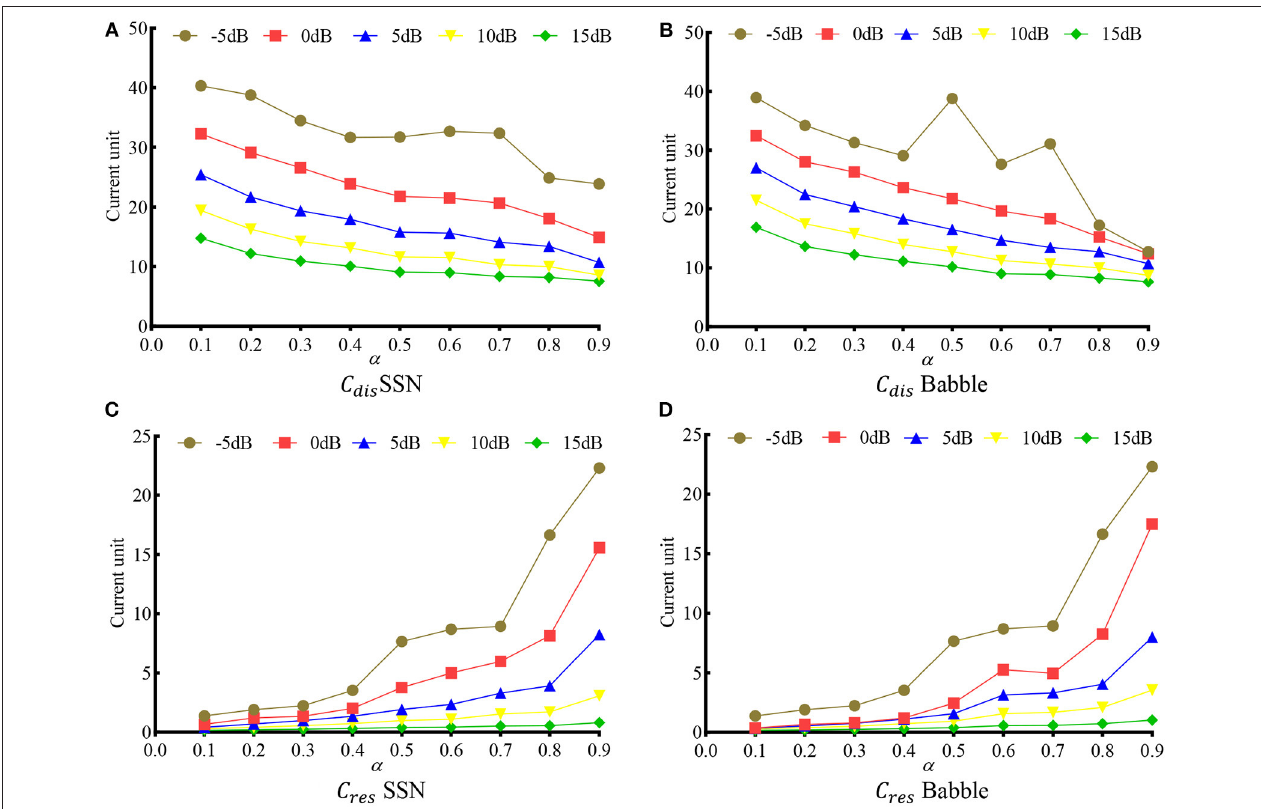
C res as a function of α in various noise conditions. (A) C dis in SSN, (B) C dis in Babble, (C) C res in SSN, and (cid:0) (cid:1)